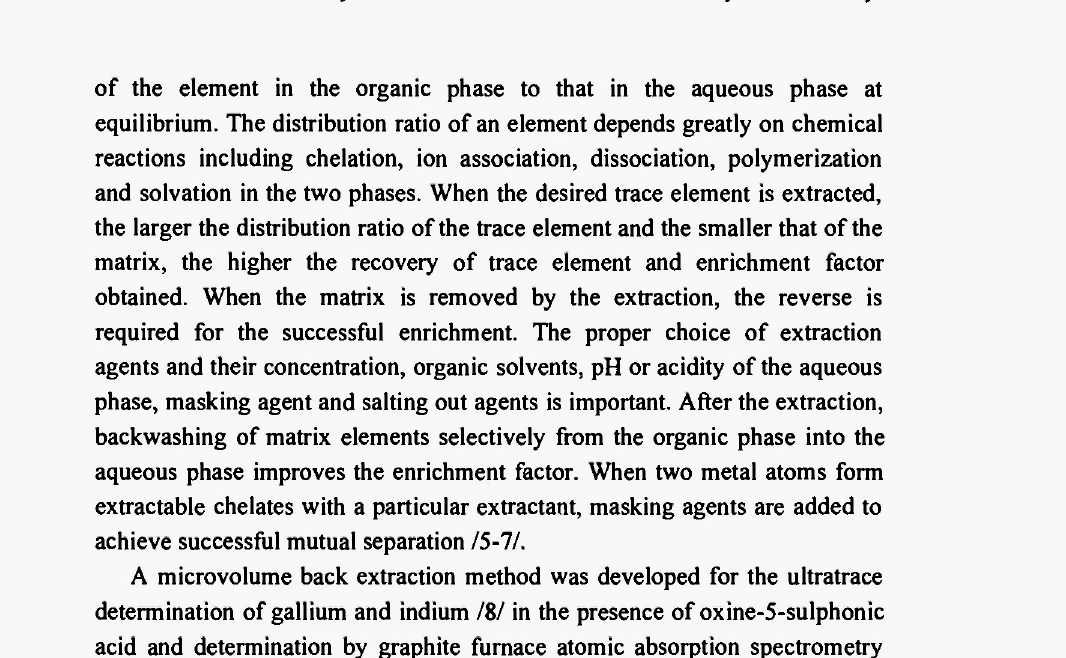
Extractive spectrophotometry procedures were developed for